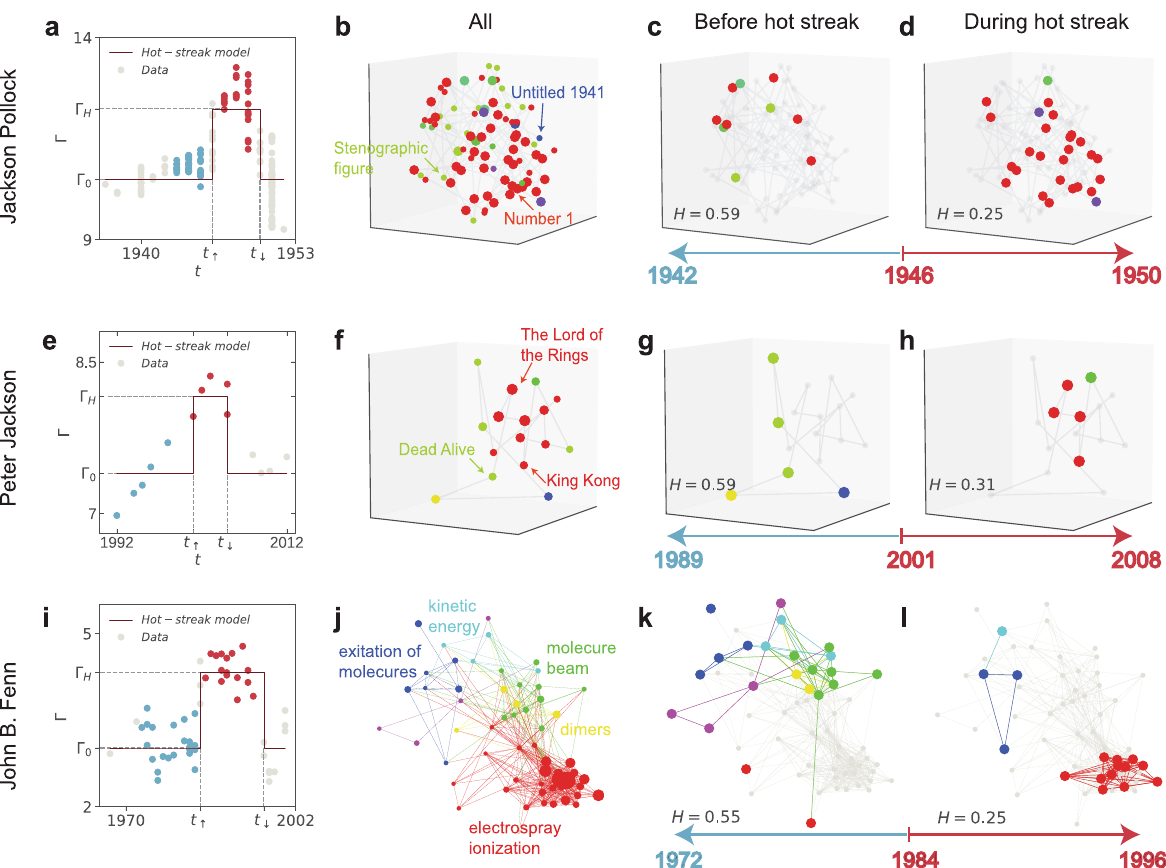
Fig. 2 Creative trajectories and hot-streak dynamics: three exemplary careers. a , e , i We fi t the hot-streak model to careers of a Jackson Pollock, e Peter Jackson and i John B. Fenn. The hot-streak model 1 assumes that the impact of works produced in a career (logprice for artworks, IMDB rating for fi lms and log C for papers) is drawn from two normal distributions ( Γ and Γ H ), where Γ captures the typical performance and Γ H captures the performance during 10 0 0 hot streak. The red line denotes the hot-streak model. t " and t # marks the beginning and the end of hot streak. To avoid mixing across the two periods, we measure the entropy of styles or topics for works produced before and during hot streak by excluding those produced during the year of the transition. b – d We project the 200-dimensional representation of artworks produced by Jackson Pollock to a 3D t-SNE embedding space. Different styles are shown in different colors, and nodes with larger sizes denote those produced during hot streak. For Jackson Pollock, his hot streak is well aligned with the famous “ drip period ” (1946 – 1950). The entropy of works produced during this period is substantially lower than typical ( H ¼ 0 : 25 vs H ¼ 0 : 43), suggesting an intensive focus on one particular style ( d ). This exploitation behavior contrasts the work he produced in the period leading up to hot streak, which was characterized by an unusual exploration of new and diverse styles ( H ¼ 0 : 59) ( c ). f – h We project the fi lms vectors produced by Peter Jackson to a